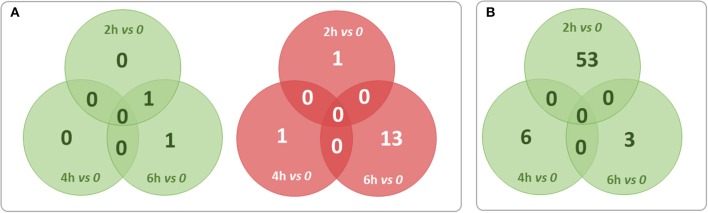
Summary of overlaps between differentially expressed transcripts only in the CF set (A) and only in non-CF set (B) at each of the respective time points against non-infected time point (0 h). Red circles represent down-regulated transcripts and green circles represent up-regulated transcripts. No transcripts were found down-regulated exclusively in non-CF set.